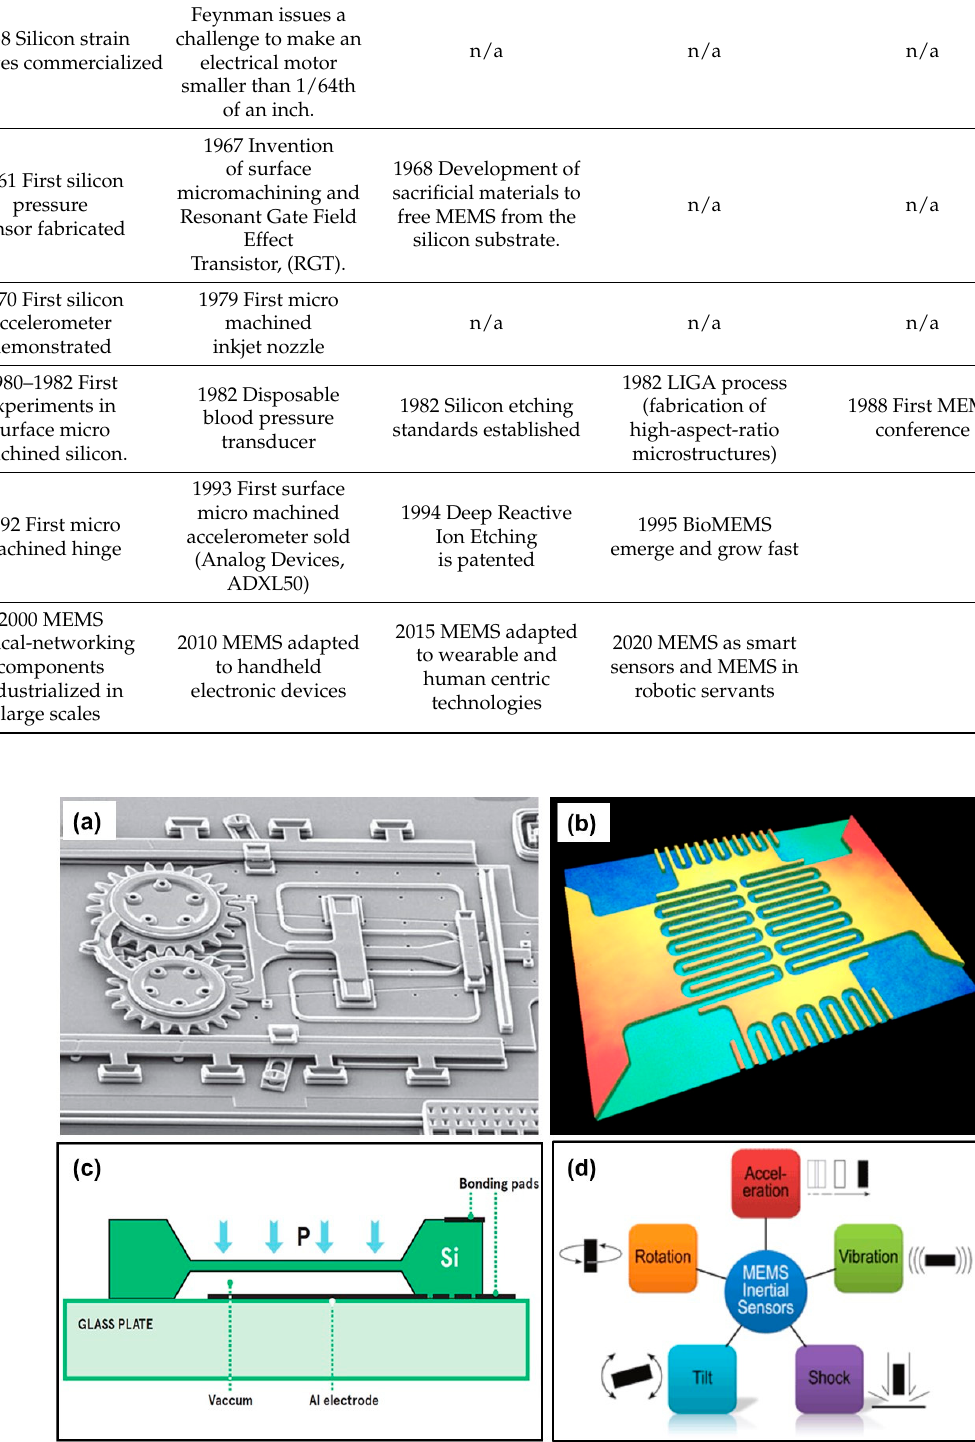
Figure 5. ( a ) A microscopic clutch manufactured from MEMS components. Reprinted/adapted with permission from Ref. [49]. Copyright 2018, The Society of Petroleum Engineers (SPE). ( b ) 3D topography of a MEMs device. ( c ) A cross section schematic of a MEMS capacitive pressure sensor and ( d ) Application areas of MEMS internal